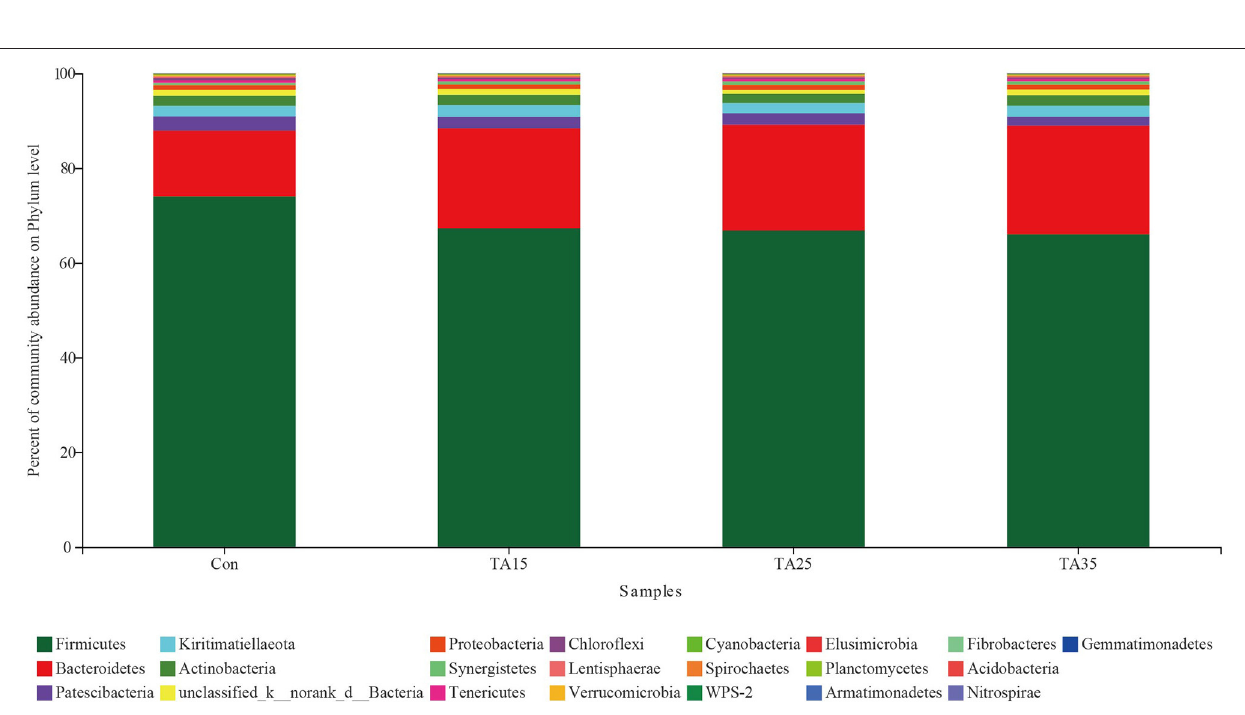
Frontiers in Veterinary Science |